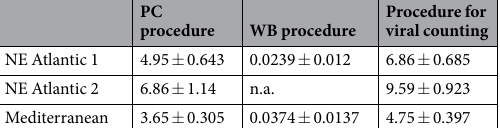
Table 1. Comparison among the abundances of viruses extracted from sediments by means of the WB and PC procedures (before the step for concentrating viruses using vacuum filtration or TFF treatment) and the procedure developed for viral counting 21 . All data are expressed as 10 8 virus g − 1 . n.a = not available. All data are expressed as 10 8 virus g − 1 . n.a = not available.